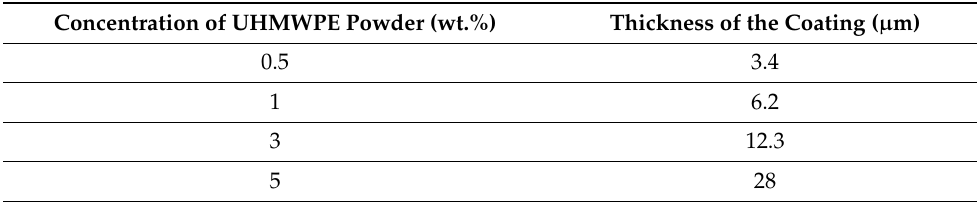
Table 4. Thicknesses of the coatings obtained by using different concentrations (wt.%) of UHMWPE polymer powder in decalin. Data From [52–57]. Concentration of UHMWPE Powder